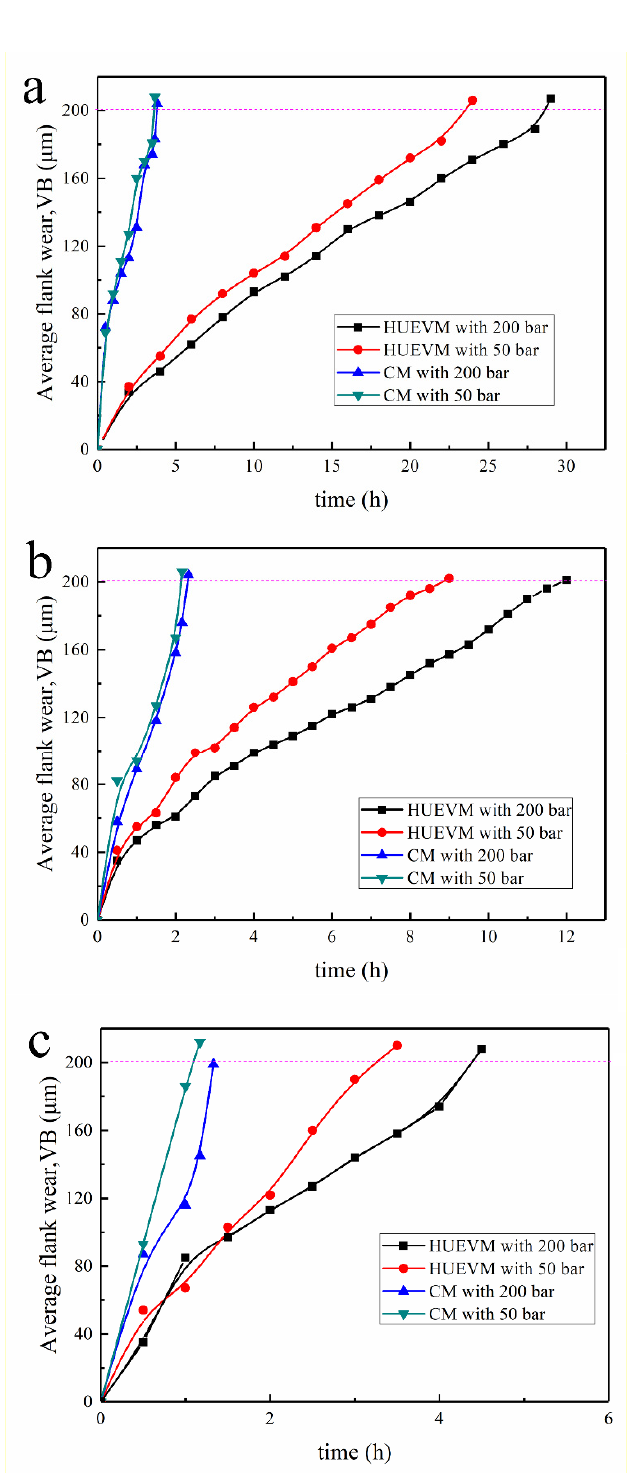
Figure 8. The variation of flank wear under different coolant pressures and cutting speeds in both HRUEM and CM: ( a ) v = 80 m/min, ( b ) v = 120 m/min and ( c ) v = 160 m/min .